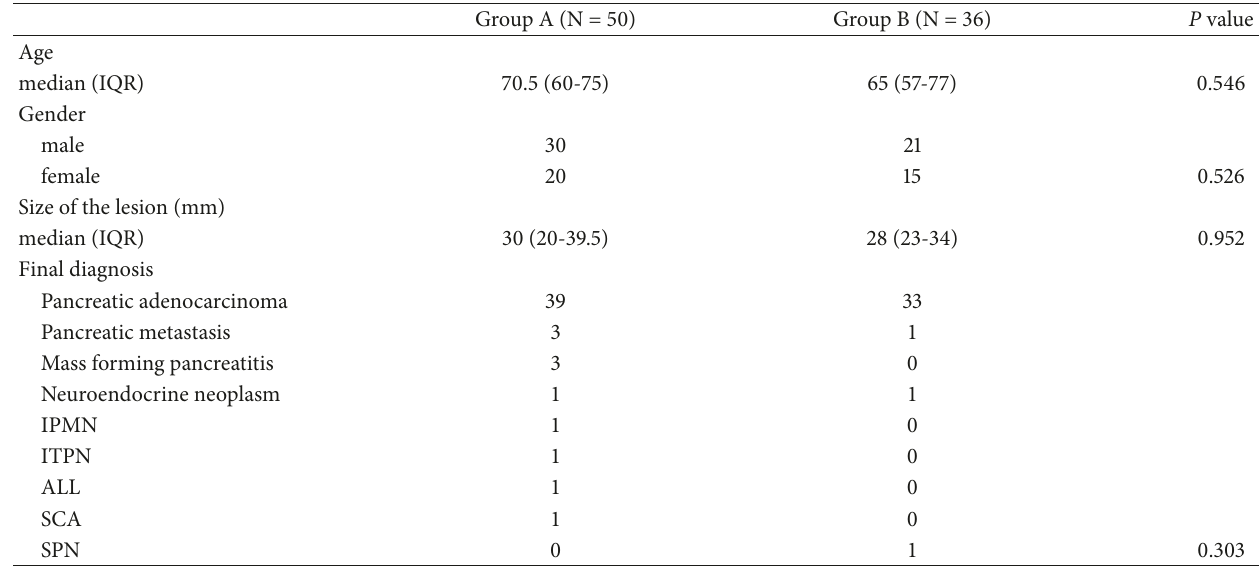
Table 1: Patient characteristics.